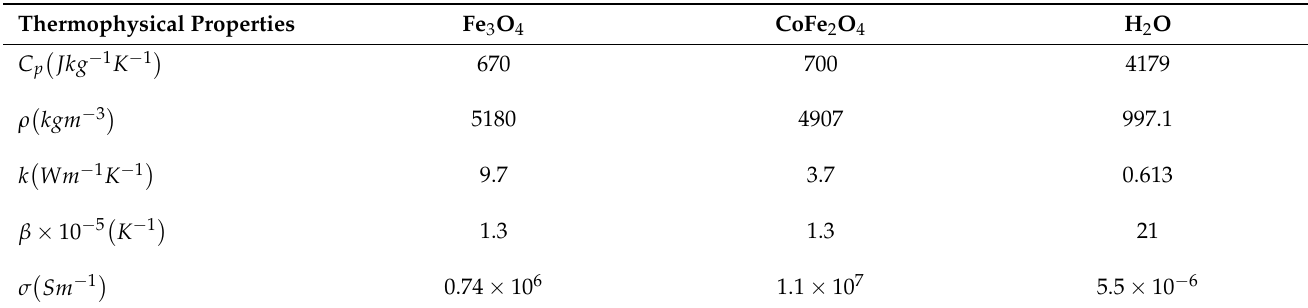
Table 2. Thermophysical properties of ferroparticles and water (base fluid)